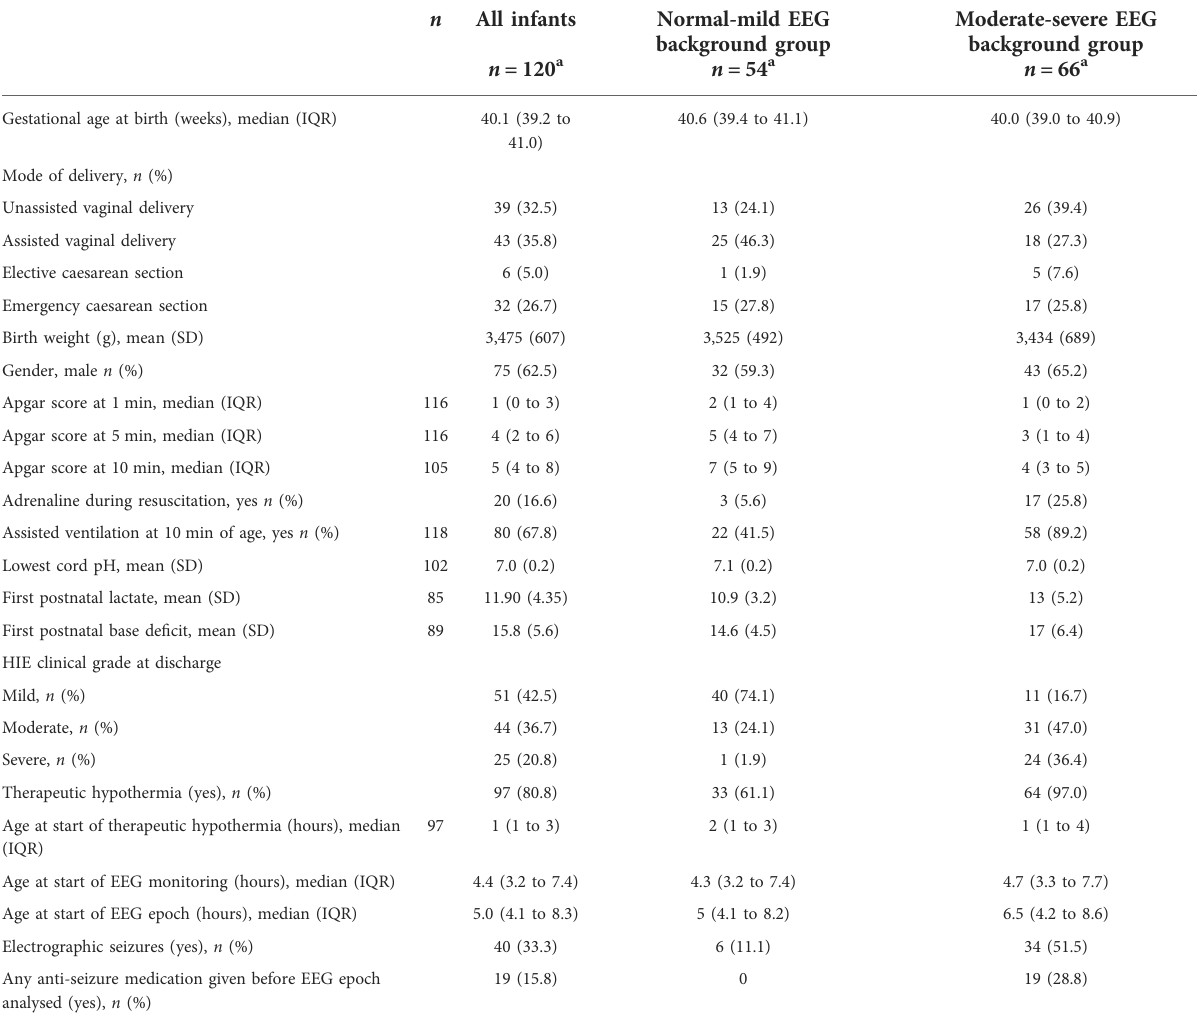
TABLE 1 Study cohort